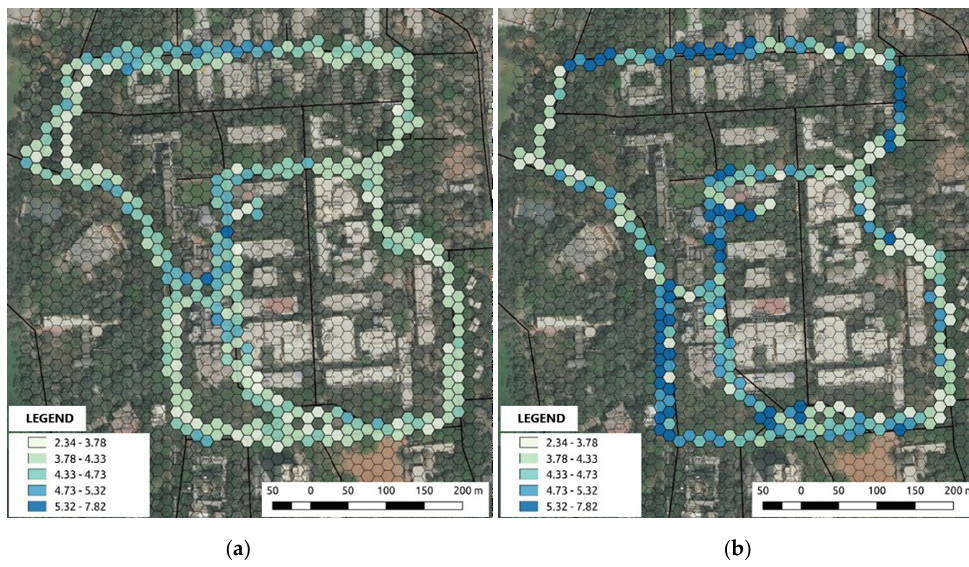
Figure 5. The difference in Shannon entropy values during the morning ( a ) and evening ( b ) hours.